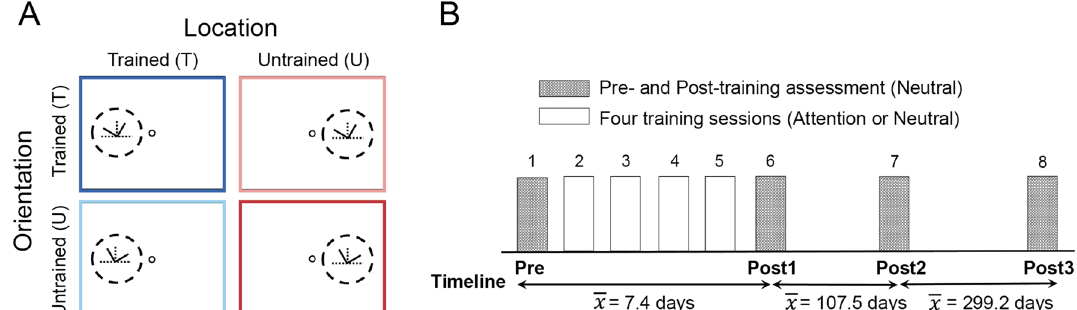
Figure 2. Illustration of the experimental conditions and protocol in the perceptual learning study. ( A ) Trained and untrained conditions in the testing sessions. The dark blue, light blue, light red, and dark red panels represent trained location/orientation (TL, TO), trained location/untrained orientation (TL, UO), untrained location/trained orientation (UL, TO), and untrained location/orientation (UL, UO), respectively. ( B ) Schematic illustration of the 6-day VPL experiment. Observers were tested on day 1 (Pre-test) and day 6 (Post-test 1), and were trained with a neutral cue or an attentional cue on days 2–5 depending on their assigned group. Observers performed an identical testing session 3–4 months (Post-test 2) and more than 1 year (Post-test 3) after completion of the VPL experiment to assess the duration of training effects of perceptual orientation offsets (Supplementary Figs S1,S2 online), and 75% accuracy threshold was estimated by fitting a power function (for details, see Materials and Methods). Our training protocol was effective, as confirmed by significant learning in the Neutral group (Fig. 3A, dark blue circles on sessions 1 vs. 6, t 8 = 8.973, p < 0.001, Cohen’s d = 2.880, two-tailed, paired t-test). As expected, The Neutral group showed location and orientation specificity: Learning in the orientation discrimination task did not transfer to any of the three untrained condi- tions (Fig. 3A, p = 0.97, 0.19 and 0.15 for light blue, light red and dark red circles on sessions 1 vs. 6, respectively, two-tailed, paired t-tests). We next examined whether and how training with FBA affects VPL specificity. As in the Neutral group, observers in the Attention group showed significant learning in the trained condition (Fig. 3B, dark blue circles on sessions 1 vs. 6, t 8 = 6.336, p < 0.001, Cohen’s d = 2.647, two-tailed, paired t-test). The threshold differences between